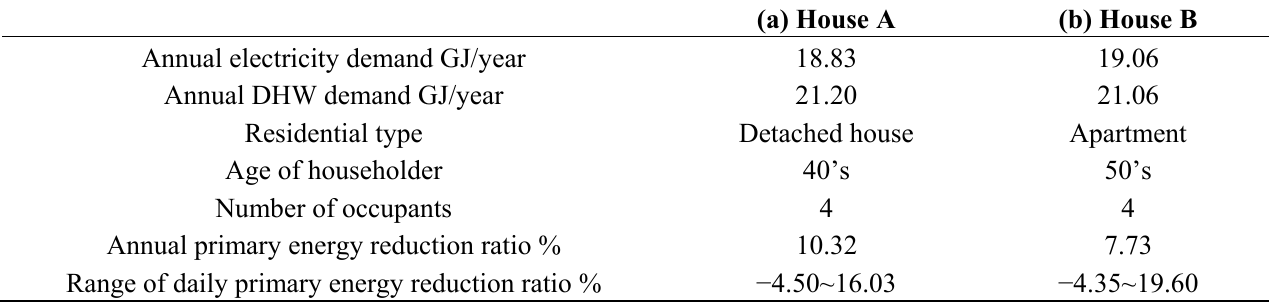
Table 4. Characteristics of the two